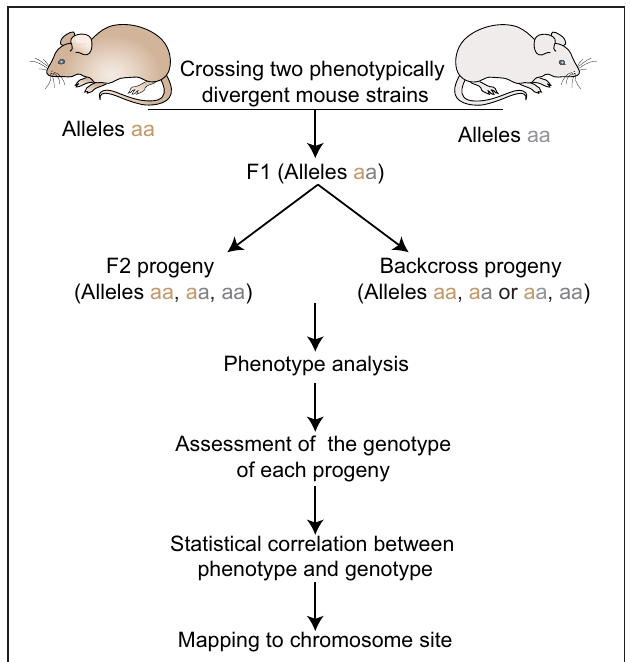
FIGURE 1 | Quantitative Trait locus mapping in inbred strains. F1 progeny are generated by crossing two phenotypically divergent strains. F1 mice can be intercrossed to produce F2 progeny or backcrossed to the parental strains to produce N2 progeny. All progenies are phenotyped and genotyped using informative markers across the genome. Statistical phenotype/genotype correlations are carried out to identify genetic loci underlying the given